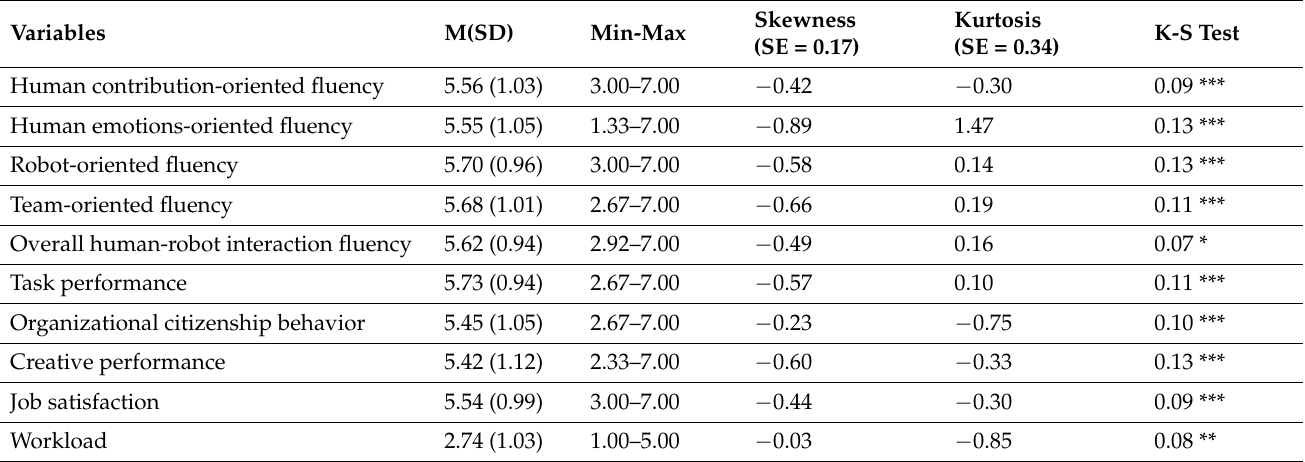
Table 1. Descriptive statistics for study